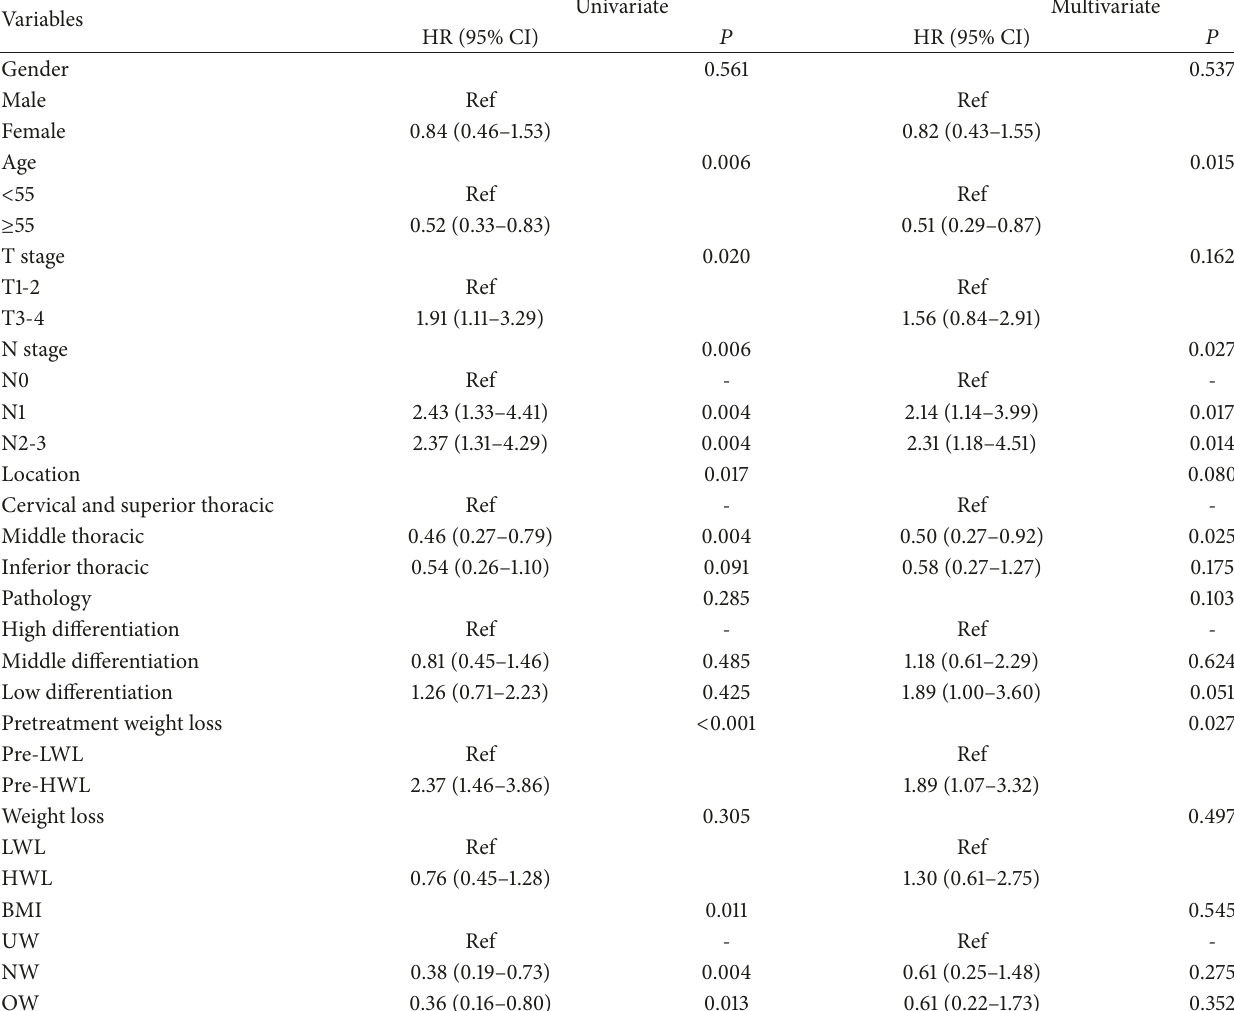
Table 3: Summary of Cox-regression analyses of the prognostic factors for 3-year overall survival ( 𝑛 =